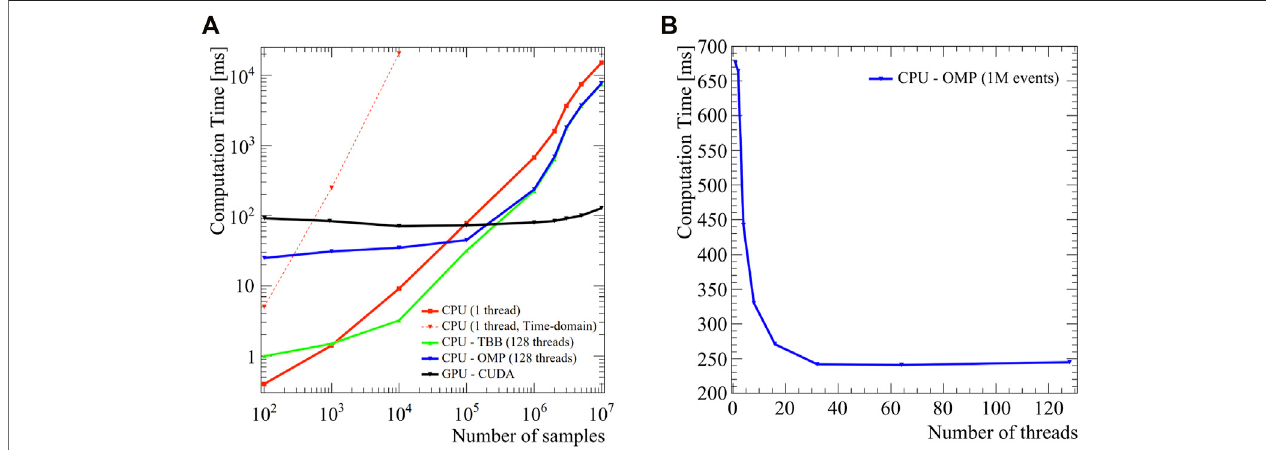
FIGURE 12 | Computation time of the convolution algorithms in TFBoost. (A) Computation time as a function of the number of signal samples for different backends. (B) Computation time using the OMP backend as a function of the number of threads, for a sample statistics of 10 6 .